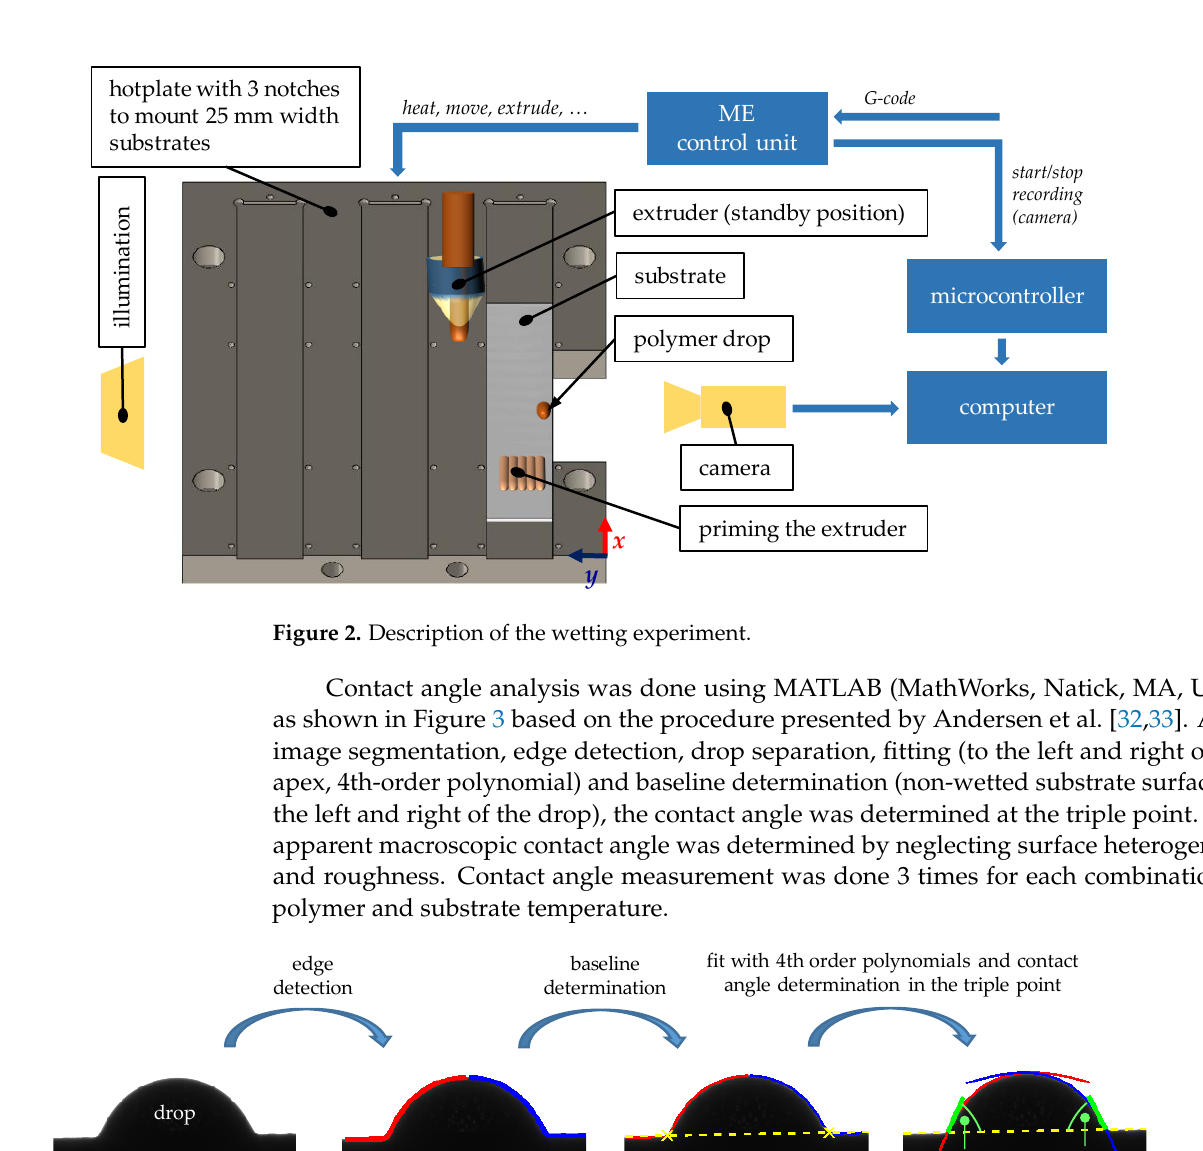
Figure 3. Determination of the contact angle, φ , as mean of the left, φ l , and right, φ r , contact angle.